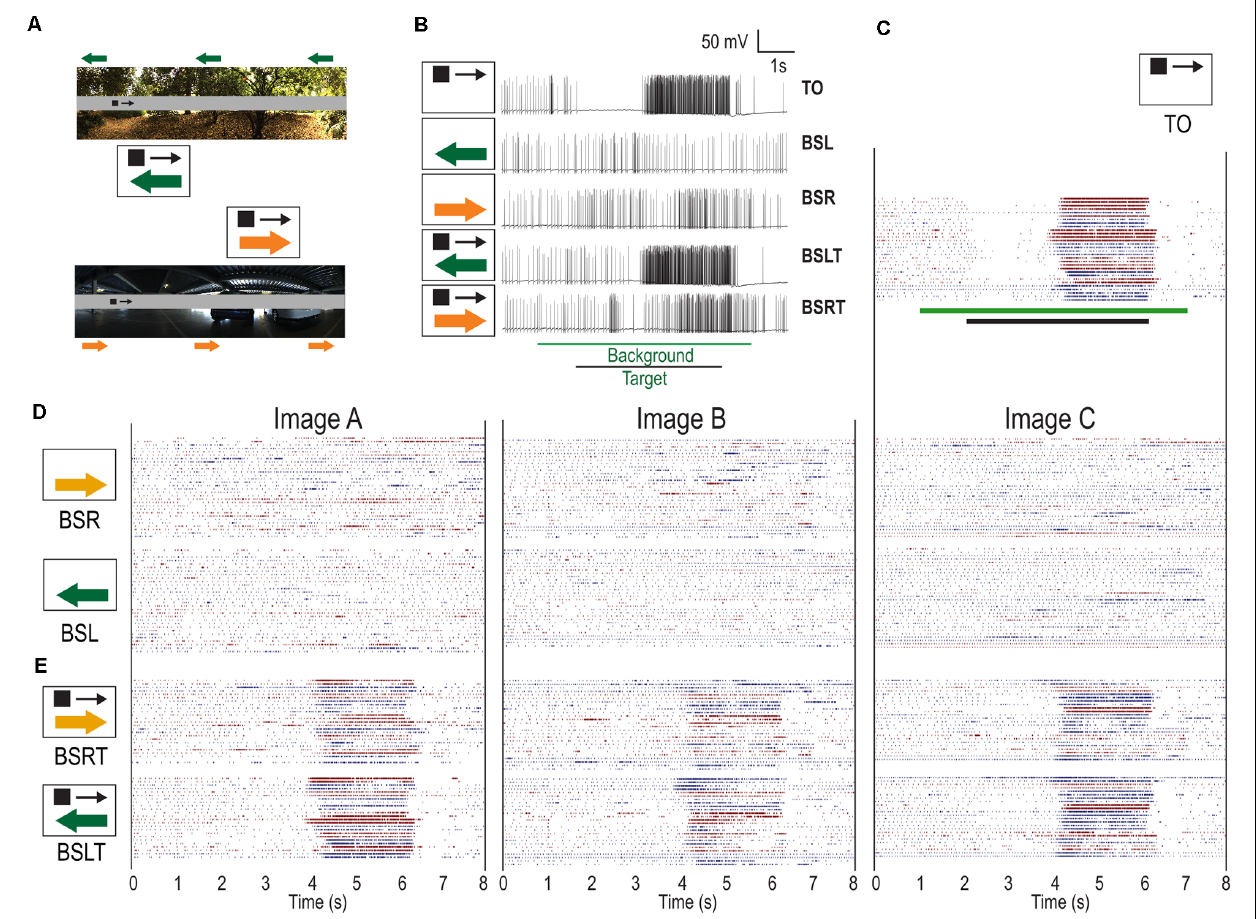
FIGURE 2 | Individual responses of CSTMD1 ( n = 12) to moving targets over moving backgrounds of either direction. (A) Example of stimuli with either a leftwards or rightwards moving background (green arrows) and rightwards moving target (black arrow). Corresponding pictograms are illustrated (not to scale). (B) Example raw traces from CSTMD1 when presented with target alone (TO), leftward moving background alone (BSL), rightward moving background alone (BSR), target with leftward background (BSLT) and target with rightward background (BSRT). Background features can both elicit activity as well as decrease responses. (C) Target only spike rasters (TO). Black stimulus bar indicates time target is moved on the display. Color changes represent different animals. Within any one animal, trials with the same phase are adjacent. (D) Responses to leftward moving backgrounds (BSL) and rightward moving backgrounds (BSR). Green stimulus bar indicates time background is moved on the display. The moving backgrounds result in sporadic responses of varying strengths. (E) Backgrounds moving in either direction, with a target moving in the preferred (BSLT, BSRT), are less responsive during the target epoch, compared to target alone (TO)